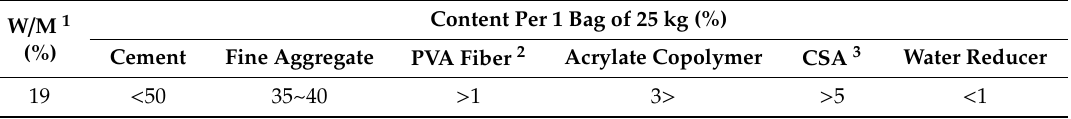
Table 3. Mix proportions of polymer mortar.